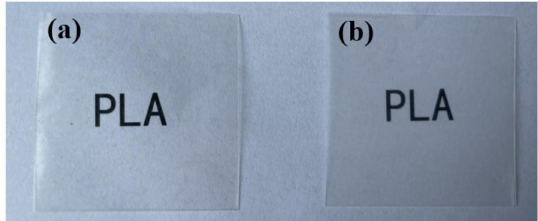
Figure 5. Pure PLA film ( a ) and P/F1 film ( b ) samples.